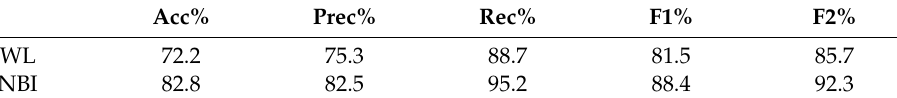
Table 19. Performance index of polyp classification.